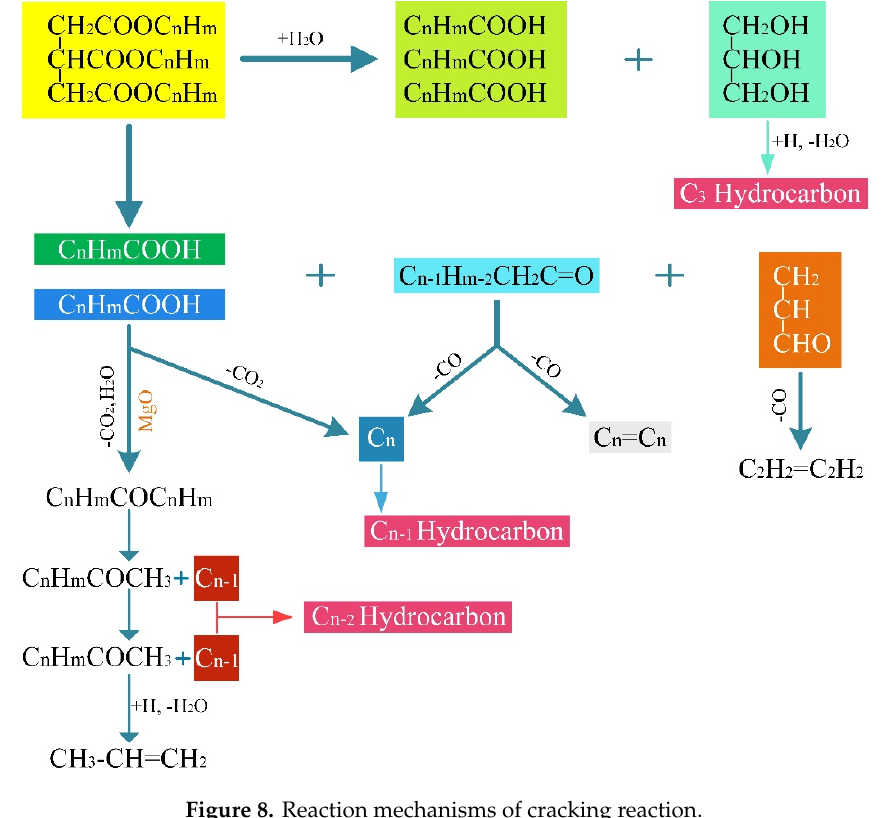
Figure 8. Reaction mechanisms of cracking reaction.